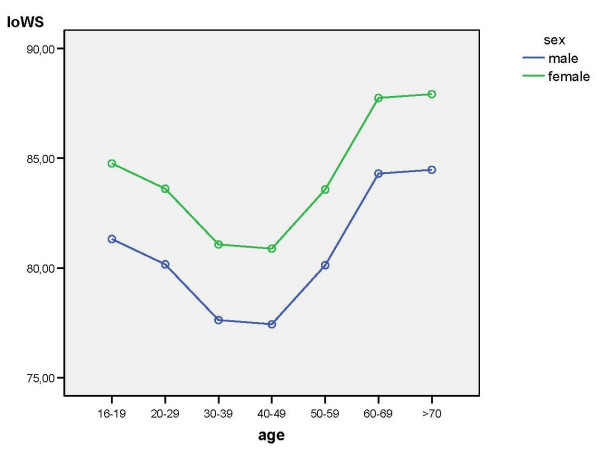
Results of the multifactorial analysis with the effects of age and gender on IoWS.